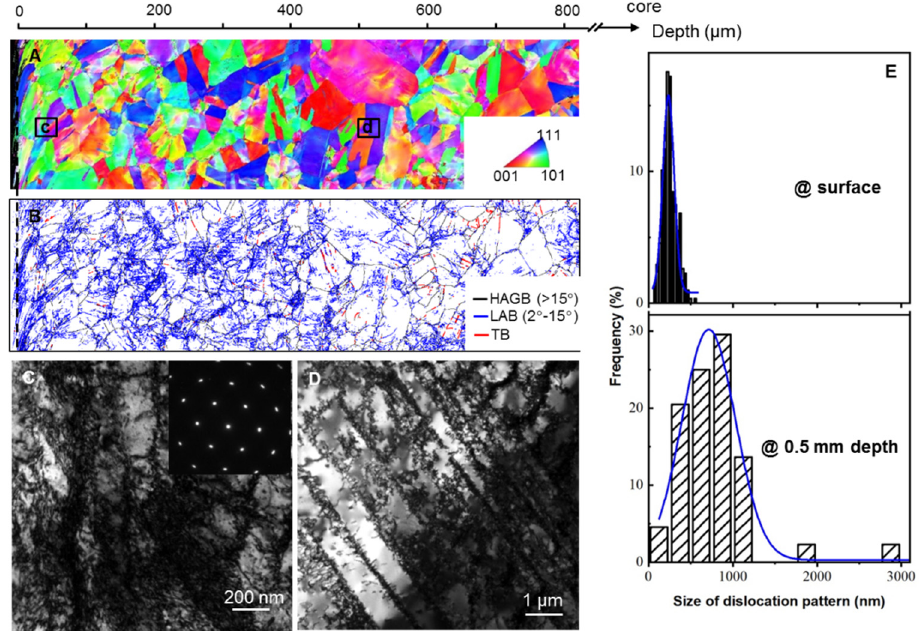
Figure 1. Cross-sectional EBSD images of the gradient dislocation structure (GDS) 304 SS processed by cyclic-torsion processing, showing the distributions of a grain-scaled morphology, orientation ( A ) and LABs ( B ) within an approximately 0.8 mm depth from the surface. The corresponding bright-field TEM images of the deformation structures at the topmost surface ( C ) and ~0.5 mm depth ( D ) of treated samples (indicated in a). The inset in C is the corresponding selected area electron diffraction patterns (SAEDs). ( E ) The corresponding statistic sizes of these dislocation patterns structure at different depths of the GDS 304 SS sample.